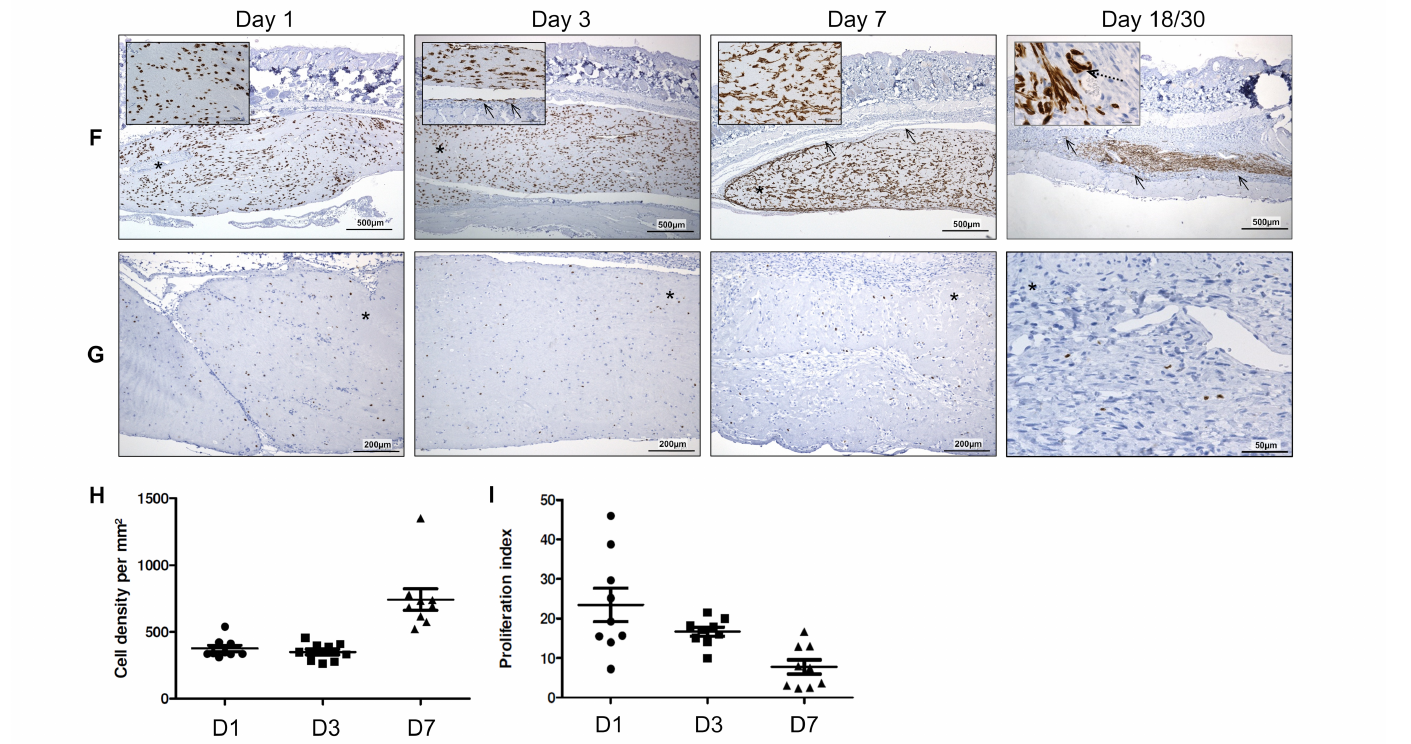
Figure 5. PLFH biodegradation, local tolerance and ASC fate after subcutaneous implantation. ( A ) Day 1, 3 and 7 after PLFH (*) implantation without (left panel) or with ASC (right panel), HE staining. Day 1 after implantation: homogeneous or focally stripped eosinophilic PLFH with a surrounding serous exudation (empty spaces) in the post-surgical pocket and a neutrophilic infiltration of both the PLFH and the murine recipients’ tissues. Minimal surrounding fibroblastic reaction was observed (black arrows). Day 3: mononuclear cells infiltrate with surrounding activated murine fibroblasts. Multifocal areas of calcium precipitates were observed (red arrows). Limited ASC death (ghost cells or empty spaces, †). Day 7: 10-15 layers of fibroblasts and collagen secretion (black arrows) surrounded PLFH. Prominent foreign body cell reaction developed around calcified areas (red arrows). Otherwise, ASC showed a typical networked fibroblast-like fusiform phenotype and secreted a clear extracellular matrix (black arrowheads). ( B ) Day 18 and ( C ) day 30 after PLFH (*) implantation with ASC (HE and Masson trichrome (MT) staining). ( B ) Day 18: dense collagenous reaction around PLFH (black arrows), and calcium precipitation with multinucleated giant cells (red arrows). Loose collagen fibers secreted by ASC and rare PLFH residual fragments (dashed arrows). ( C ) Day 30: dense collagenous matrix deposition with high ASC density and scarce residual PLFH fragments. Variable amounts of concentrated and fragmented calcium crystals (red arrows) delineated by foreign body giant cell granulomatous reaction, dense mature collagenous fibrosis and discrete angiogenesis (dotted arrows). Dense collagen fibers, secreted by ASC, replaced PLFH (MT, black arrowheads). IL-1 β ( D ) and IL-6 ( E ) gene expression. Significant difference between PLFH with or without ASC at the 0.01 level (**). ( F ) ASC morphology and persistence (vimentine IHC with brown staining of human ASC cytoplasms). Day 1: large, round ASC. Day 3: ovoid or spindle shaped ASC. Some ASC were observed at PLFH periphery (arrows on the magnified image). Day 7: dense ASC network within the PLFH. Days 18 and 30: dense ASC bundles infiltrating the PLFH together with ASC around the PLFH (arrows). Examples of ASC in perivascular positions (dashed arrow, magnified picture), in connective tissue and underlying muscle fibers (arrows). ( G ) ASC Ki-67 nuclear labeling: the number of positive cells decreased until day 30. ( H ) Cell density increased between day 1 and 7. ( I ) Proliferation index decreased from 20% (day 1) to 5% (day 7). Nine animals by timepoint and by group were used, except for 18 days (6 animals by